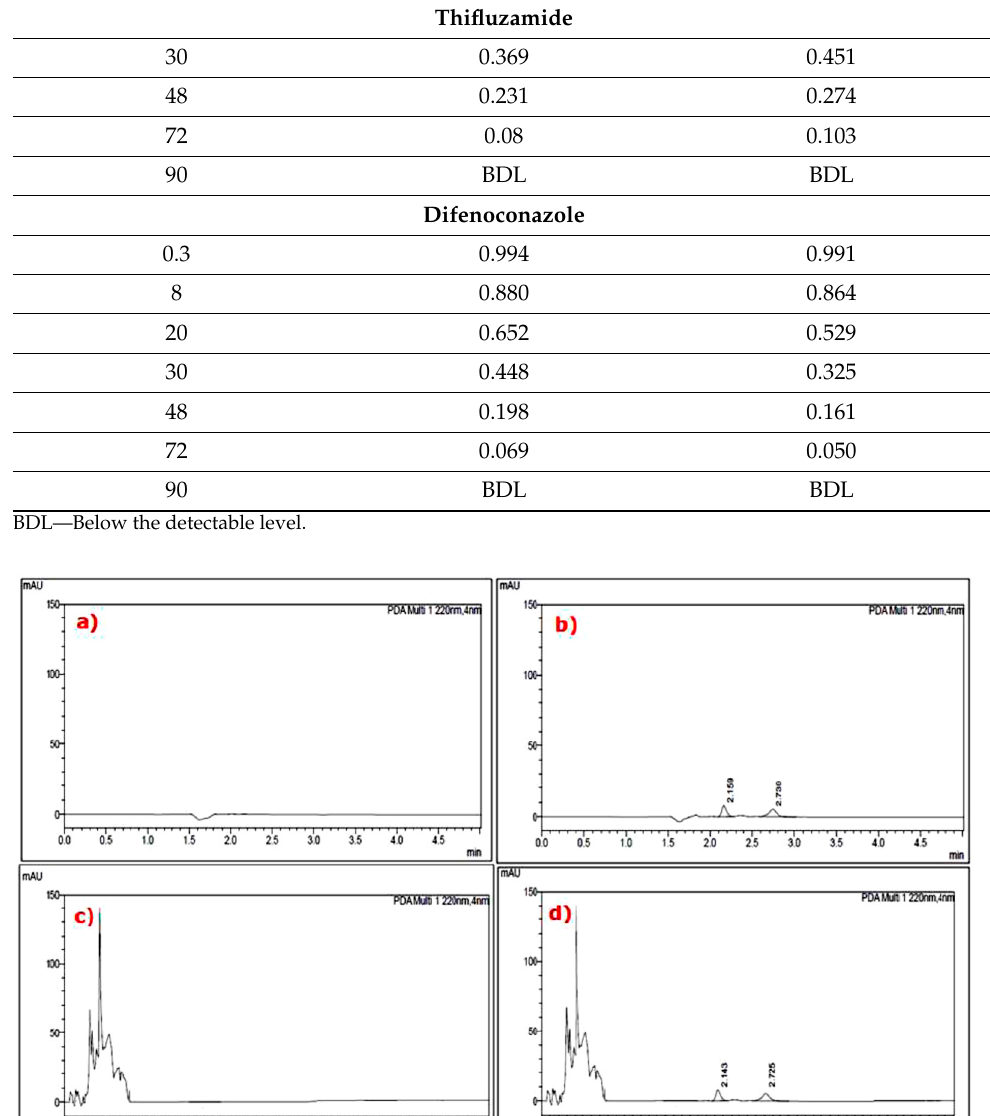
BDL—Below the detectable level. Table 7. The intensity of solar radiation measure at different time intervals (hours).